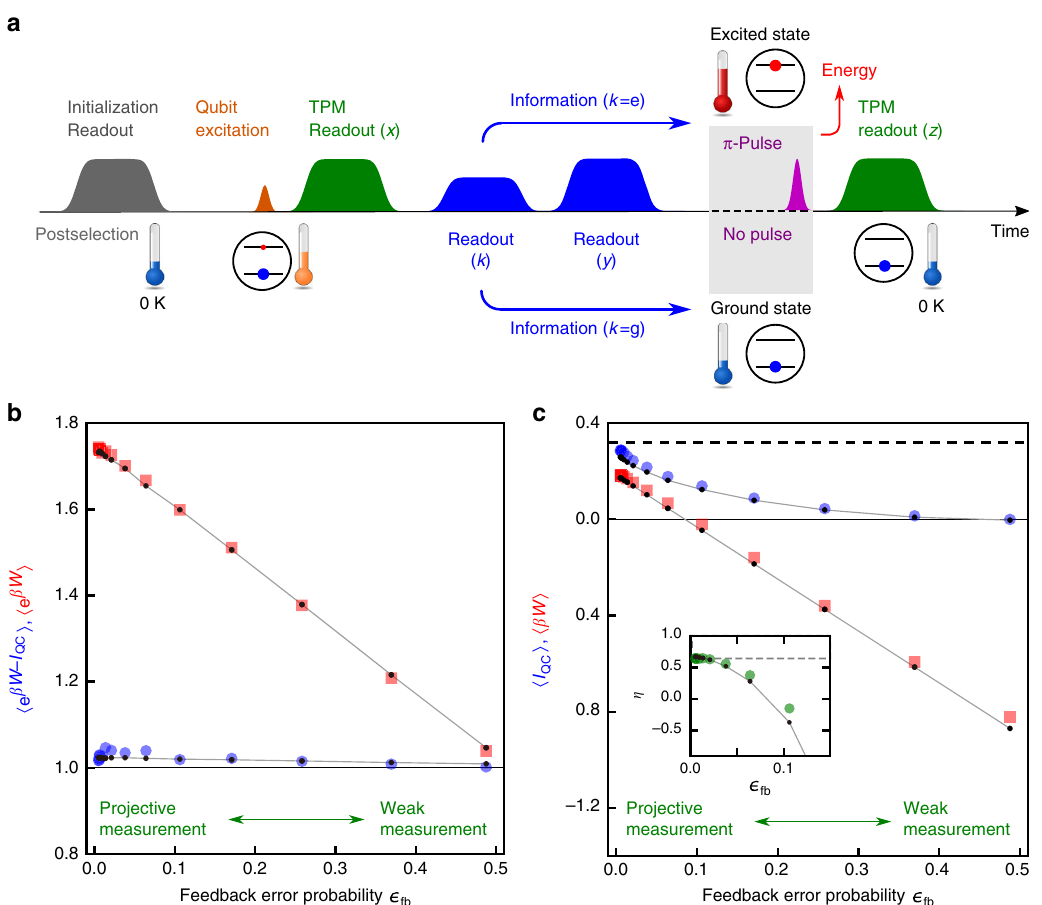
Fig. 3 Effects of the feedback error on the fl uctuation theorem and the second law of thermodynamics. a Pulse sequence. Two readout pulses are inserted between the two TPM pulses in Fig. 2a. The outcome k ( = g or e) obtained by the readout with a variable pulse amplitude is used for the feedback control. The feedback error probability ϵ fb is a function of the measurement strength. The subsequent readout with outcome y projects the qubit state before the feedback control. See Supplementary Note 2 for details. b Experimentally determined e β W (cid:1) I QC error probability ϵ fb . c I QC h i (blue circles) and β W h i (red squares) vs. ϵ fb . The black dashed line represents the Shannon entropy I Sh h i state, which is prepared at the effective temperature T = 0.14 K with the excited state occupancy of 0.097. Line-connected black dots in b , c show the simulated results incorporating the effect of qubit relaxation (Supplementary Note 2). Inset in c : information-to-work conversion ef fi ciency η (green circles) and the simulated result (line-connected black dots). The gray dashed line indicates the value for the ef fi ciency in the limit of the projective measurement due to the absolute with the theoretical value of 1 − λ fb (blue solid curve), where p ( x , z ) is the joint probability of observing a particular combination of the outcomes x and z (Supplementary Note 1).